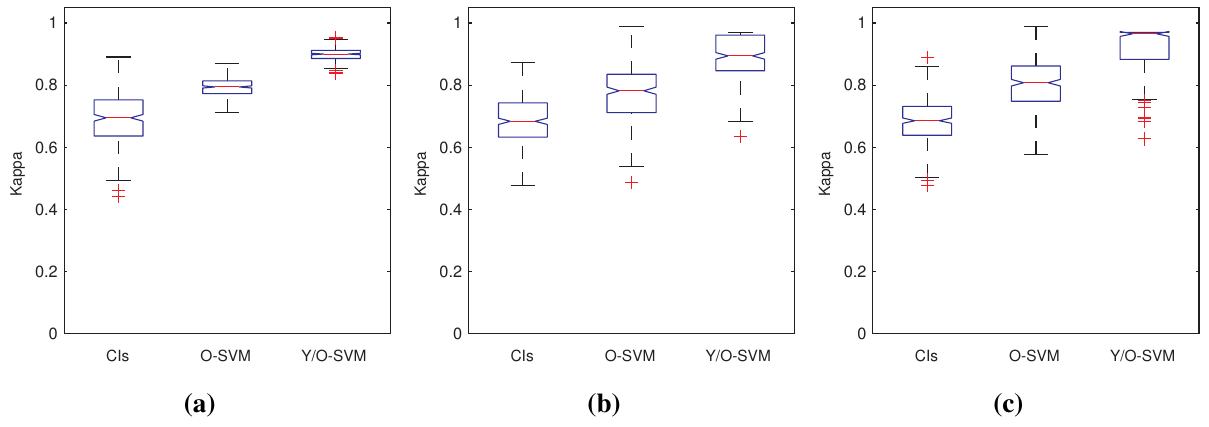
Figure 6. Box plots of the Kappa statistic yielded by each class of dataset. ( a ) Errors for homogeneous series; ( b ) errors for multi-modal series; ( c ) errors for noisy